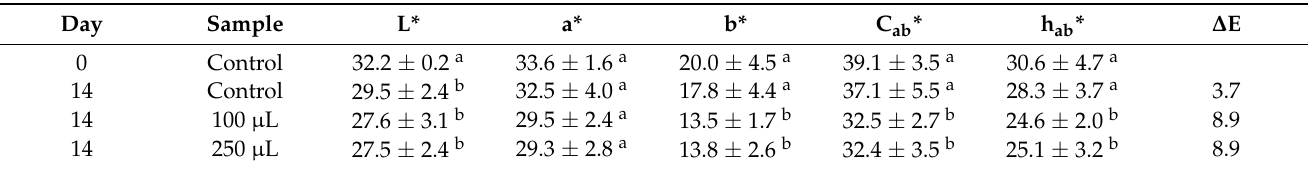
Table 4. Color parameters of the strawberries on days 0 and 14, L*, a*, b*, C ab *, h ab *, and ∆ E for each reference compared to the initial time.